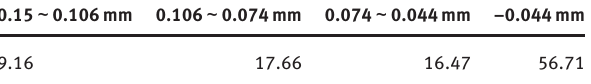
Table 2: Particle size of pyrite cinder (mass/%).